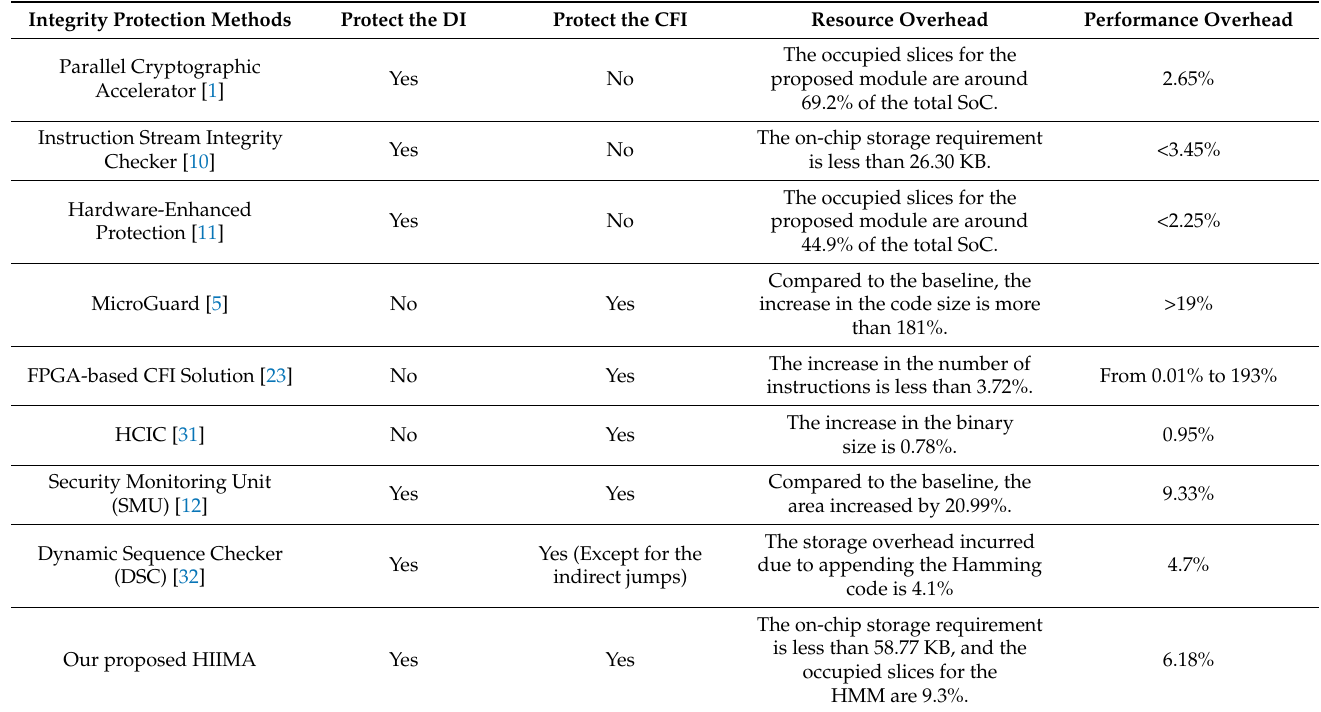
Table 9. The comparison of security and